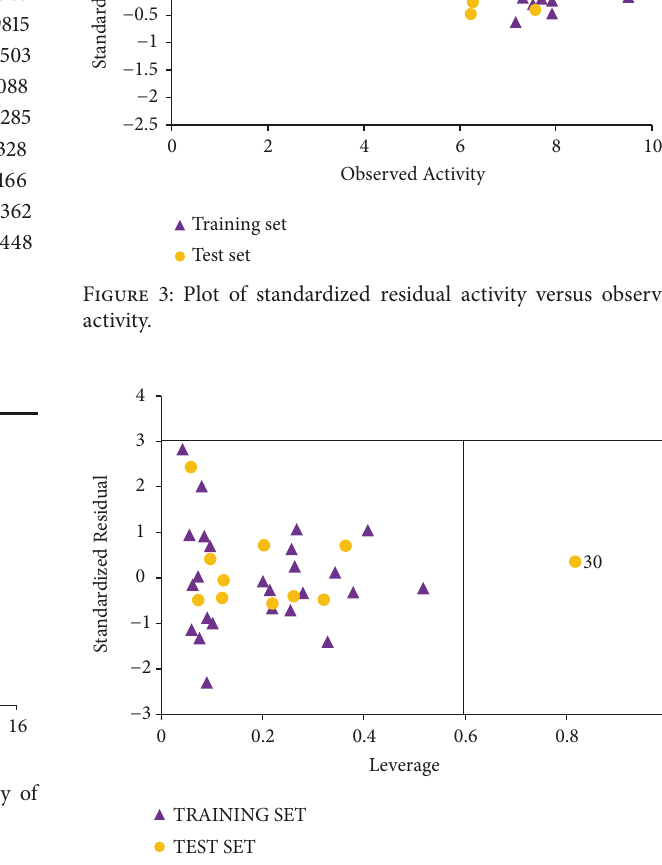
Figure 4: The Williams plot of the standardized residuals versus the leverage